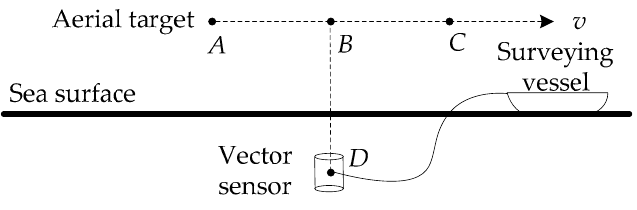
Figure 8. The profile of the sea experiment layout.